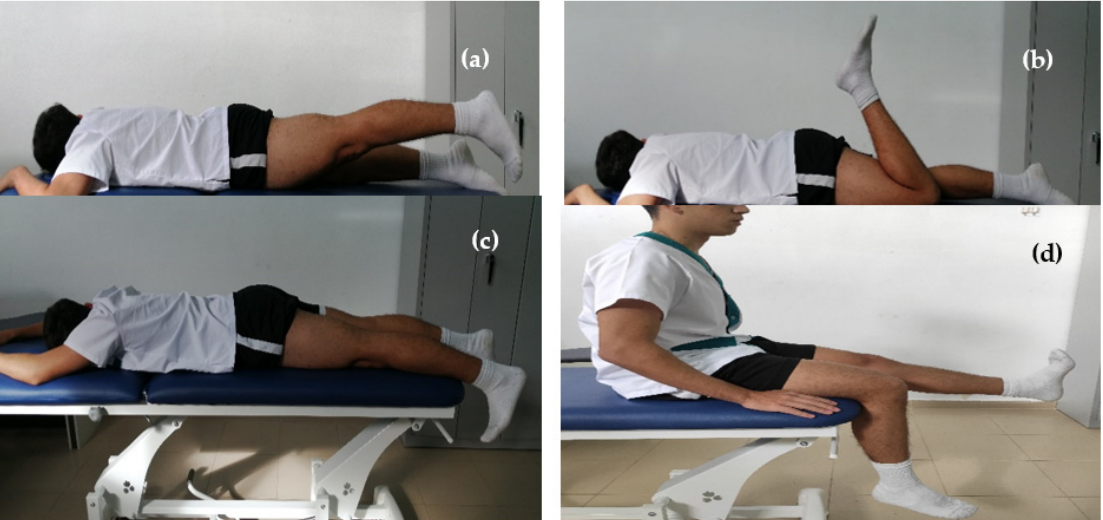
Figure 2. Pre-activity routine through exercise components. ( a ) leg extension in isometric; ( b ) active mobilization with knee flexion and extension; ( c ) neurodynamic tensioner with ankle dorsiflexion; ( d ) neurodynamic slider with active knee extension.